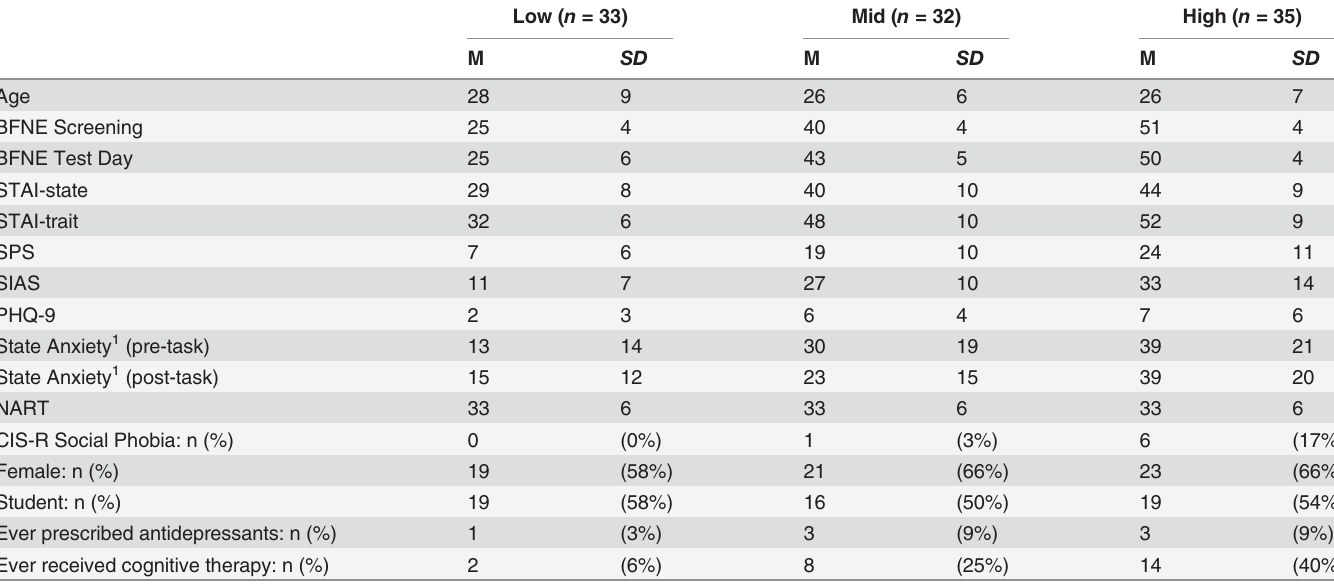
Table 1. Participant